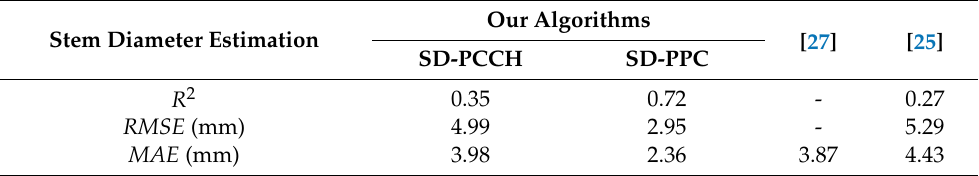
Table 2. The comprehensive evaluation results for SD-PCCH and SD-PPC.